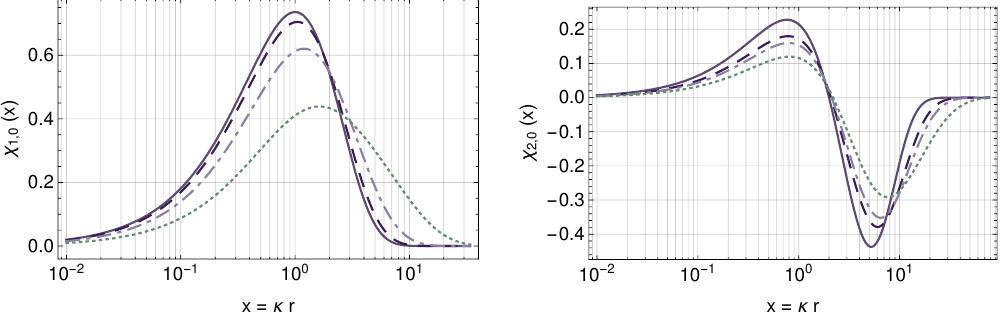
Figure 14 . Left: the bound-state wavefunction (cid:31) ( x ), for various values of (cid:24) (cid:17) (cid:22)(cid:11)=m ’ : n =1 ;‘ =0 analytical Coulomb limit (cid:24) ! 1 (solid), (cid:24) = 3 (dashed), (cid:24) = 1 : 5 (dotdashed), and (cid:24) = 1 (dotted). Right: the bound-state wavefunction (cid:31) ( x ), in the Coulomb limit (cid:24) ! 1 (solid), and for n =2 ;‘ =0 (cid:24) = 6 (dashed), (cid:24) = 5 (dotdashed), and (cid:24) = 4